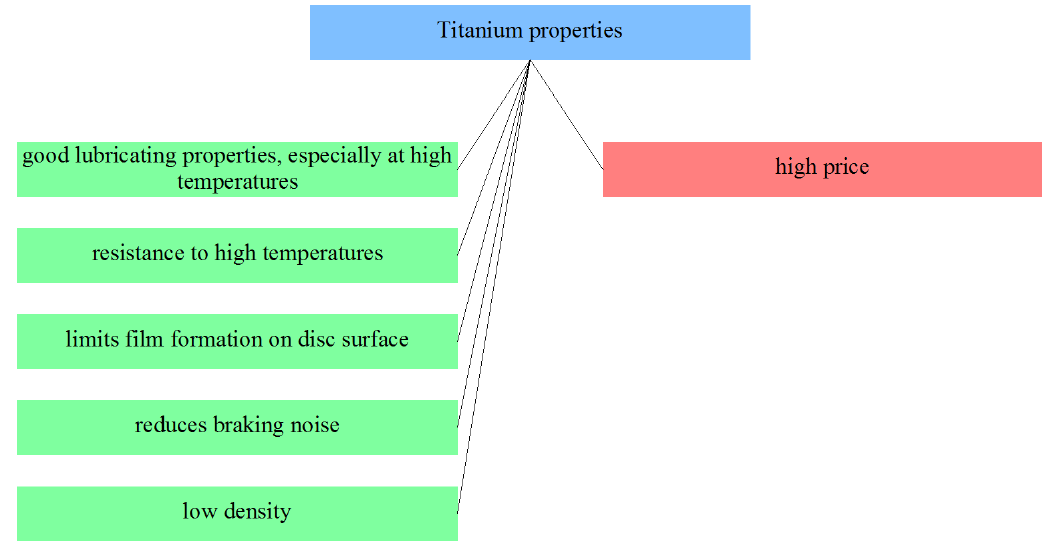
Figure 24: Selected titanium composites properties from the point of view of applicability in friction materials